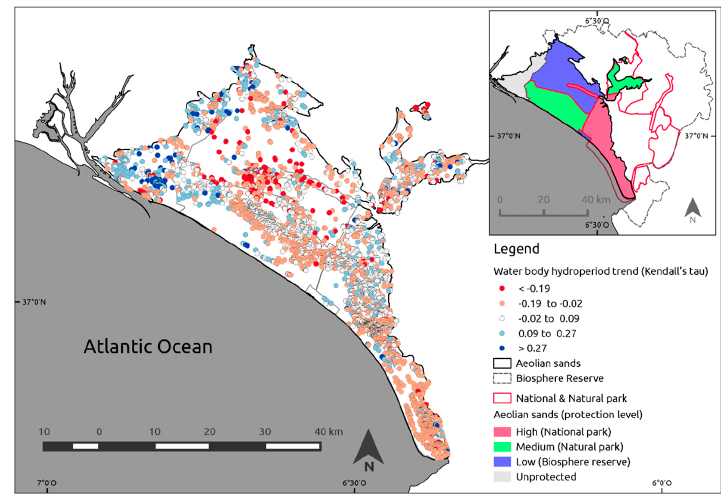
Figure 7. Hydroperiod trend (Kendall’s tau) of water bodies on the Doñana’s aeolian sands. Points represent the centroid of the water body. Blue colors represent increasing hydroperiods and red colors decreasing hydroperiods. The reference image indicates with color the levels of protection.